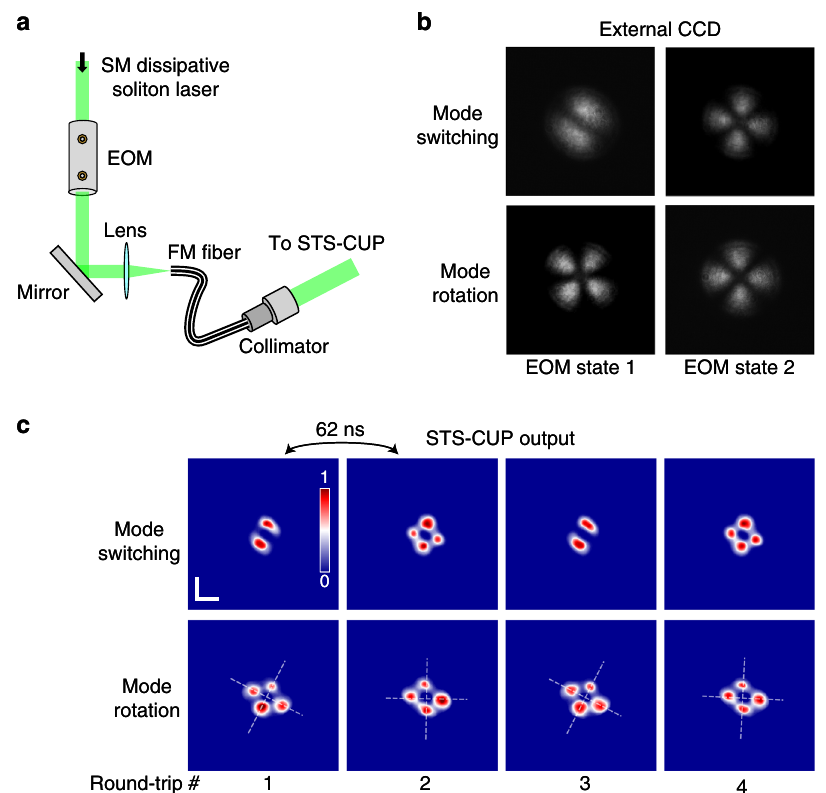
Fig. 3 Generation and single-shot capture of dynamic linear polarization modes. a Schematic for generating dynamic LP (linear polarization) modes varying every round trip. The output from an SM (single mode) DS (dissipative soliton) mode-locked fi ber laser was launched into a 30 MHz EOM (electro- optic modulator) acting as an ultrafast wave plate before being coupled into a length of FM (few-mode) fi ber. The EOM operated in a binary fashion at a frequency equal to half of the repetition rate of the DS laser, i.e., 8 MHz in this case, such that every other DS generated a different spatial pro fi le. b Generated spatial pro fi les as captured by an external CCD for comparison. In this case, the modulation frequency of the EOM was reduced to 1 Hz to match with the speed of the CCD, i.e., every 8 million DSs had the same spatial pro fi le. Two different EOM states modulated at 1 Hz were demonstrated — mode switching and mode rotation; also see Supplementary Movies 1 and 2. c Round-trip DSs captured by STS-CUP for the same EOM states but modulated at 8 MHz. Scale bar is 400 µ